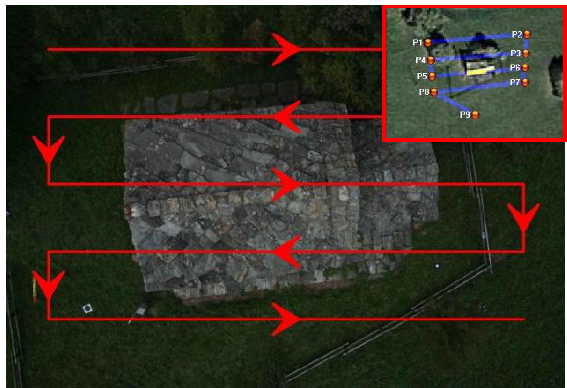
a circular flight (Figure 5) with the camera axis oriented at 45° to perform oblique acquisition.